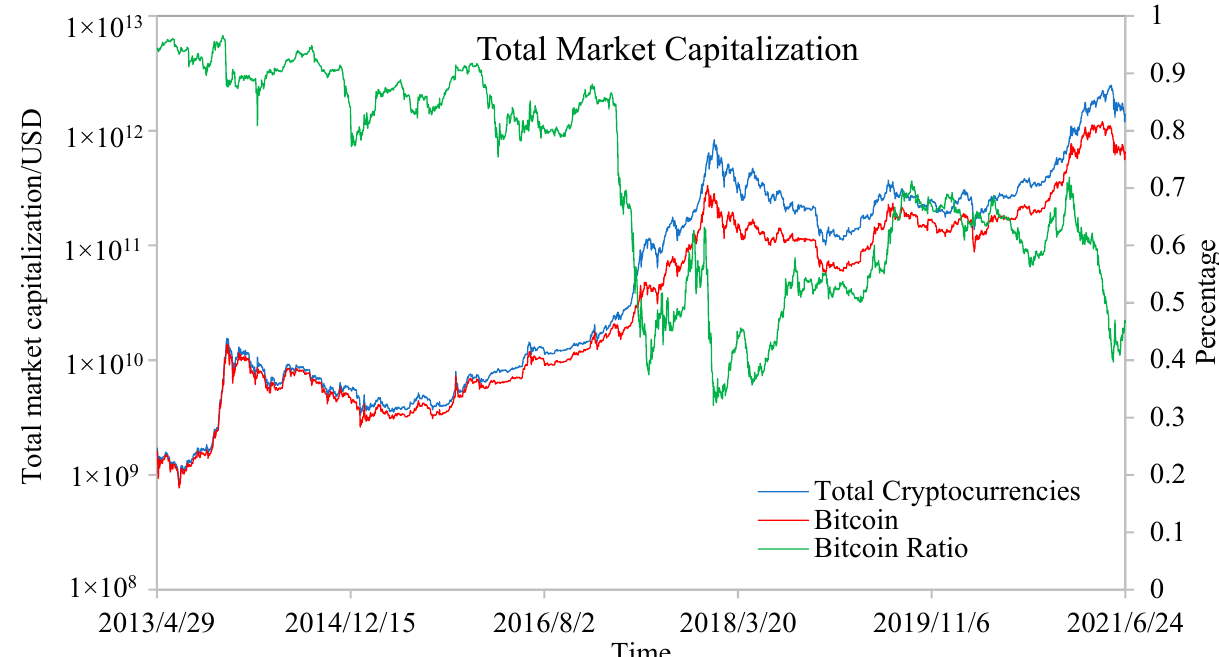
Figure 1. Evolution of the total market capitalization of cryptocurrencies and Bitcoin as well as Bitcoin ratio from 29 April 2013 to 24 June 2021.